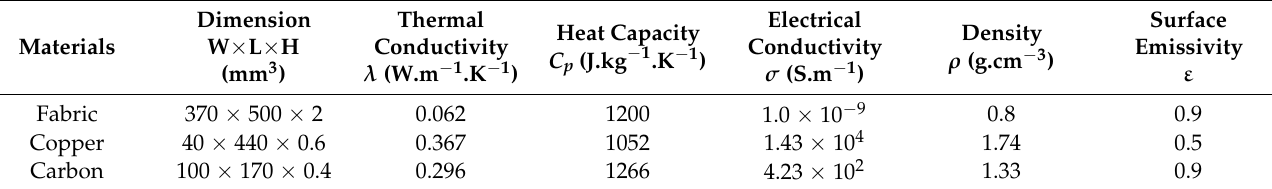
Table 3. Measured thermal conductivity of coated and neat fabric